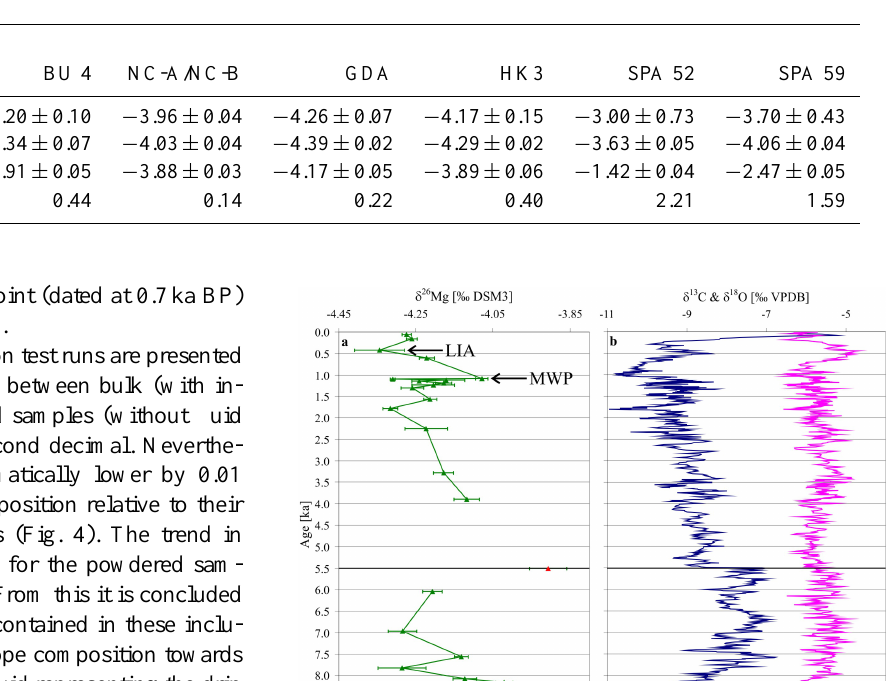
Table 3. Mean Mg-isotope ratios, minimum and maximum values and 1 26 Mg (difference between maximum and minimum value) of speleothems discussed here. Number of samples used for statistics varies between 6 and 36.